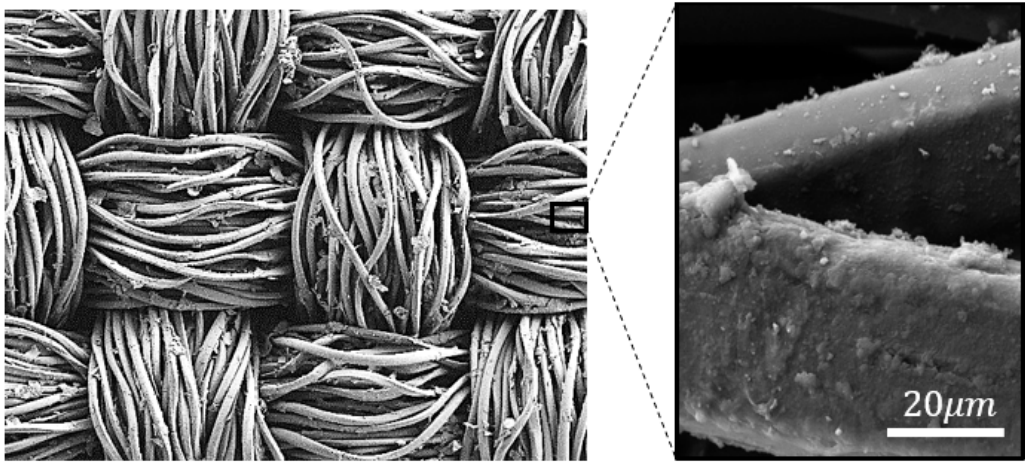
Figure 7. SEM image of PPy-coated PET fabric treated with plasma. Table 3. Resistance values of coated fabrics with plasma pre-treatment.